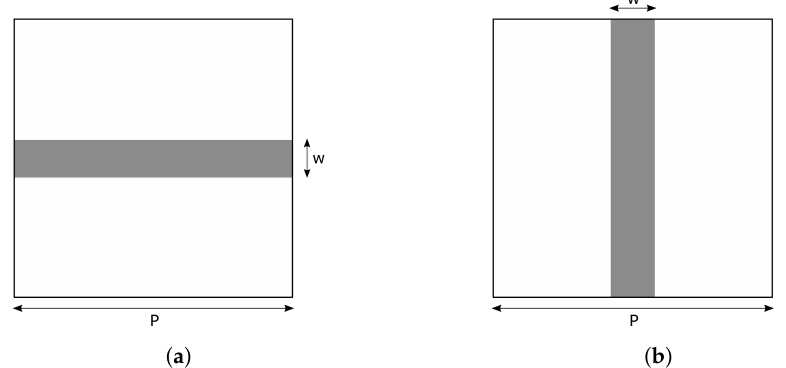
Figure 2. Geometry of strip unit cells. ( a ) Perpendicular strip unit cell; ( b ) parallel strip unit cell.